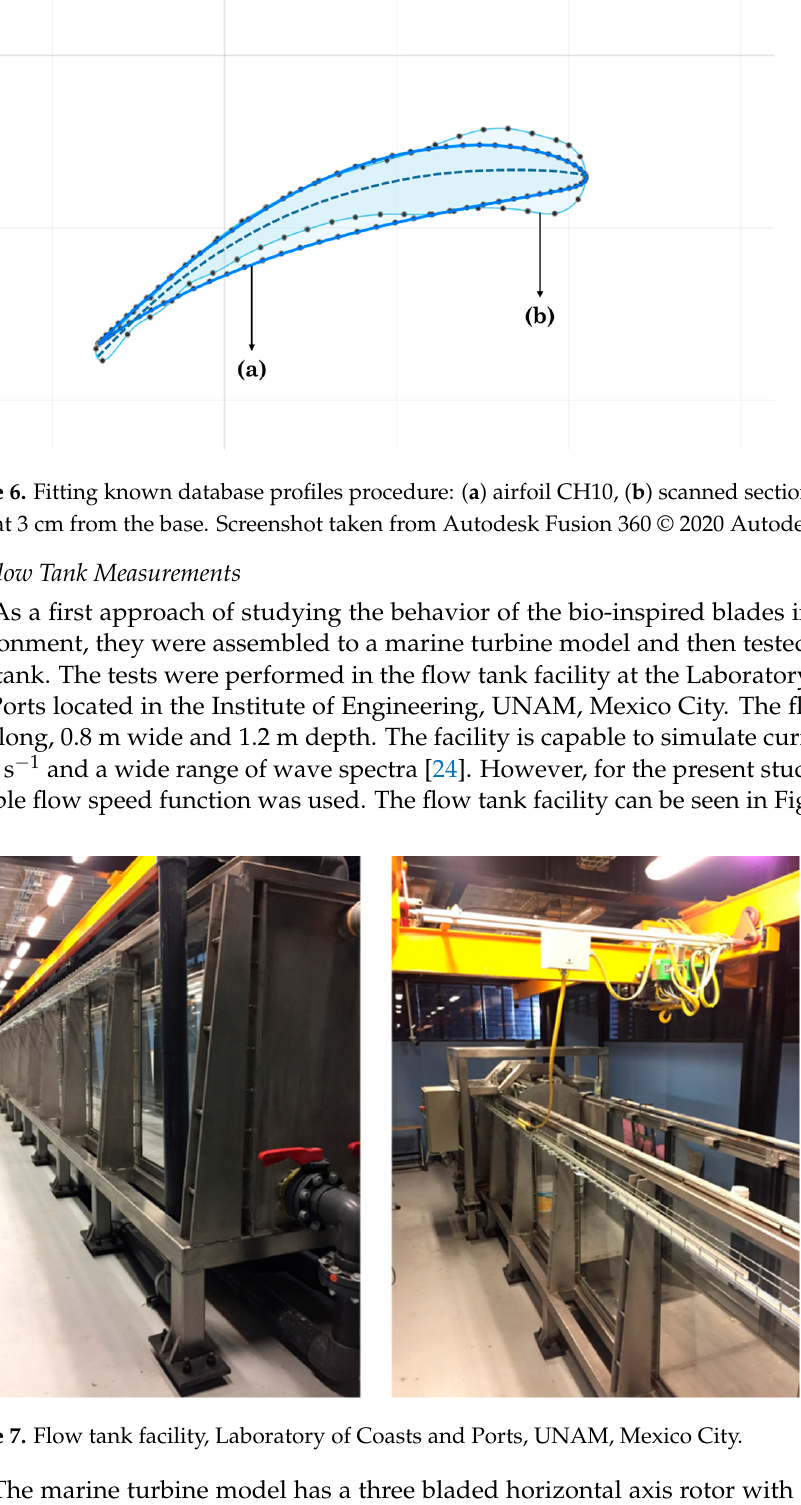
Figure 7. Flow tank facility, Laboratory of Coasts and Ports, UNAM, Mexico City.